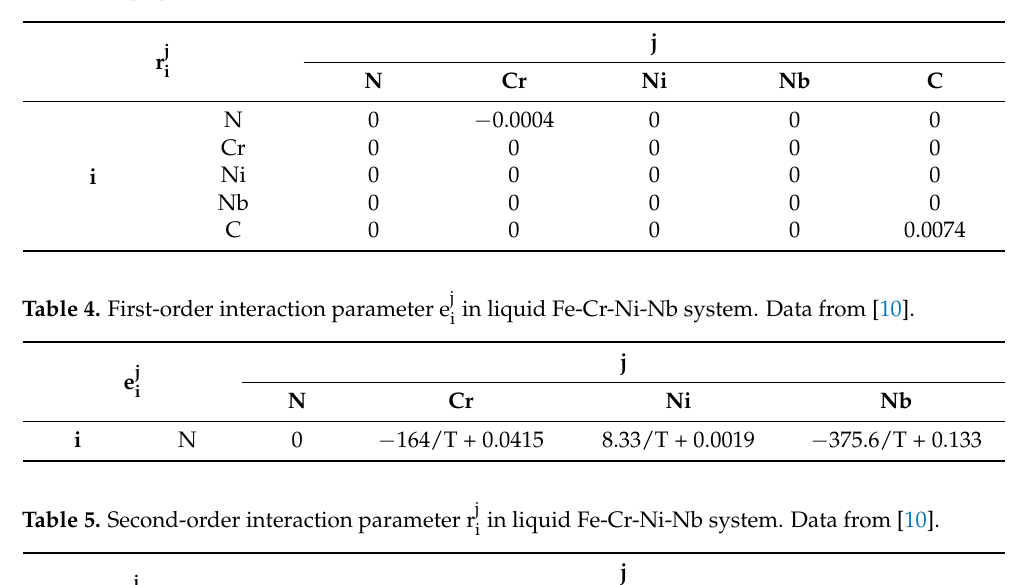
in dilute liquid iron for selected elements at 1873 K. i